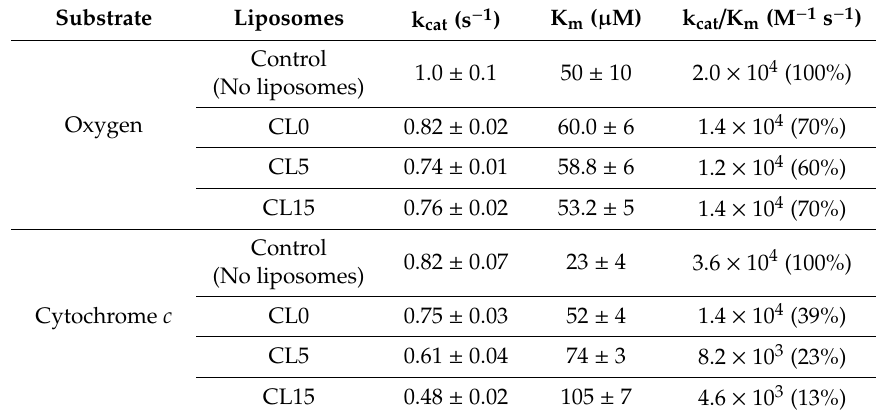
Table 1. Summary of the kinetic parameters determined in various conditions, at 25 °C, pH 7.4.